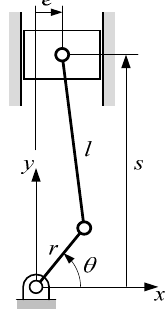
Figure 1. Slider-crank mechanism.